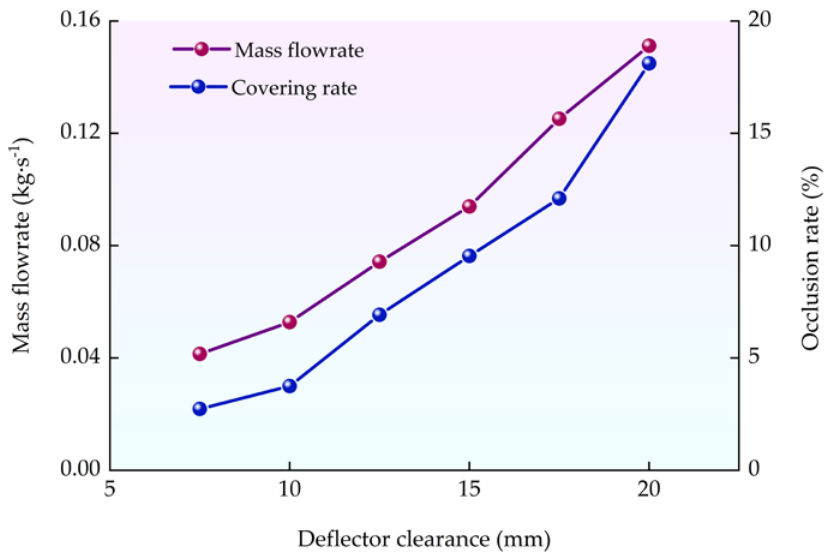
Figure 14. The variation curve of impurity occlusion rate and grain mass flow rate with the deflector